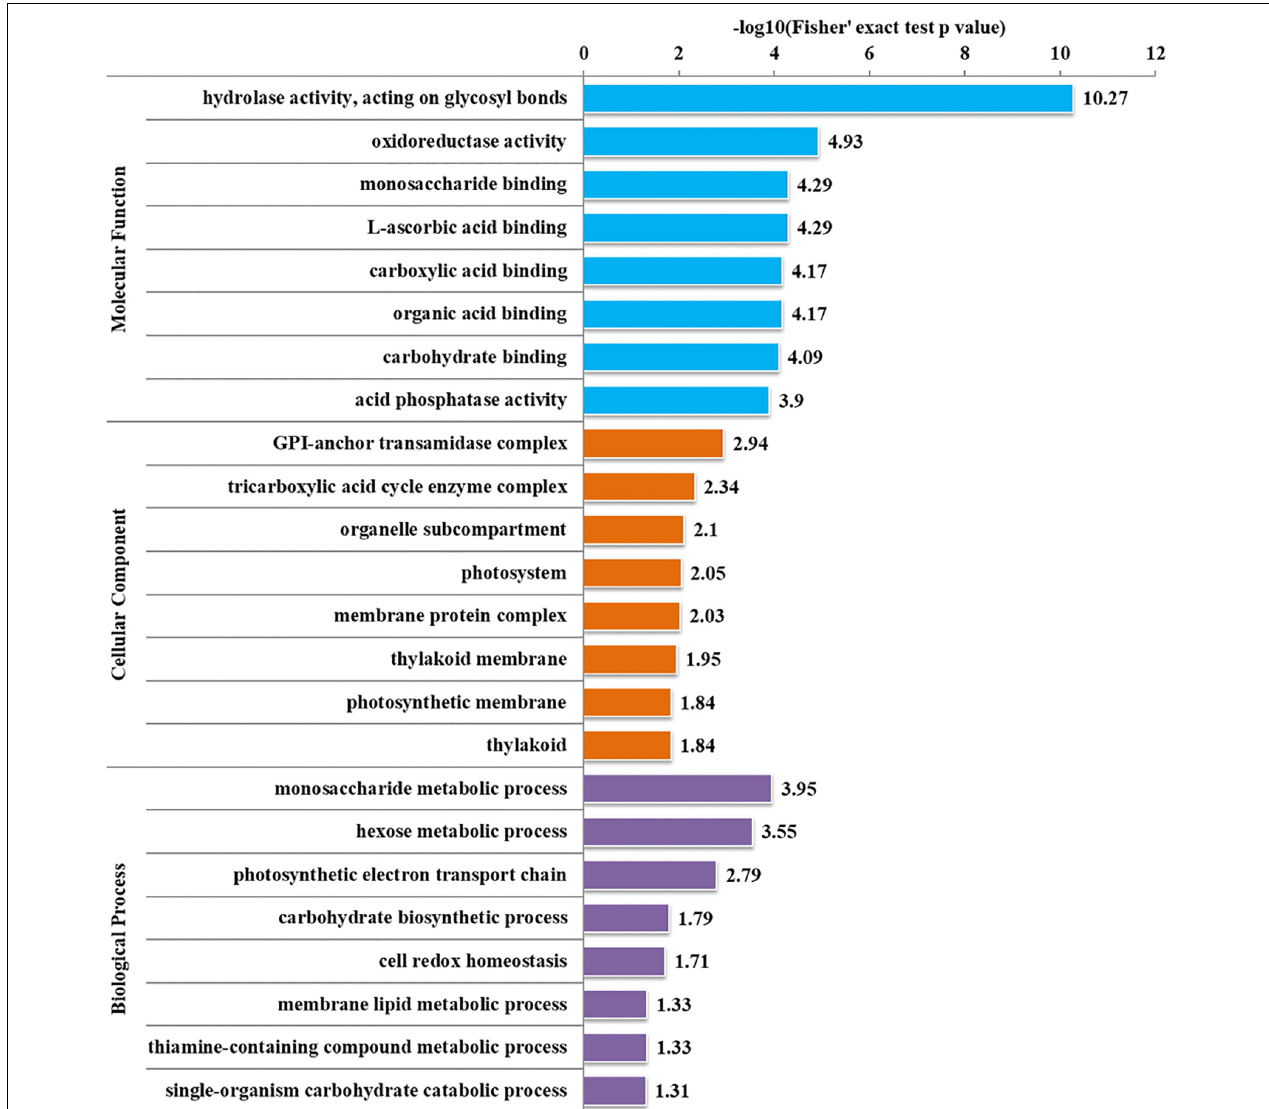
FIGURE 4 | Enrichment analysis of the N-glycoproteins based on Gene Ontology (GO) annotation. Gene ontology annotation based on the three main catteries: “Biological Process,” “Cellular Component,” and “Molecular Function.” –log10 (Fisher’s exact test p -value): p -value is adjusted by Fisher. The − log10 (Fisher’ exact test p value) is higher, the enrichment is more